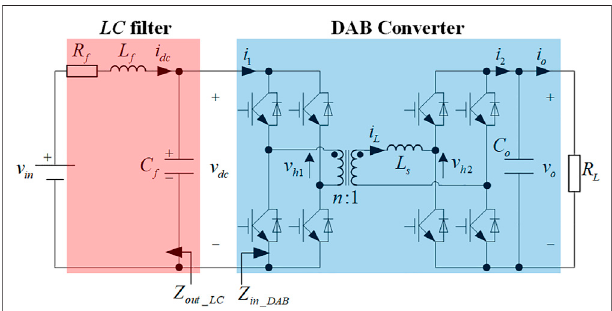
FIGURE 2 | Circuit topology of the DAB converter with its input LC fi lter.